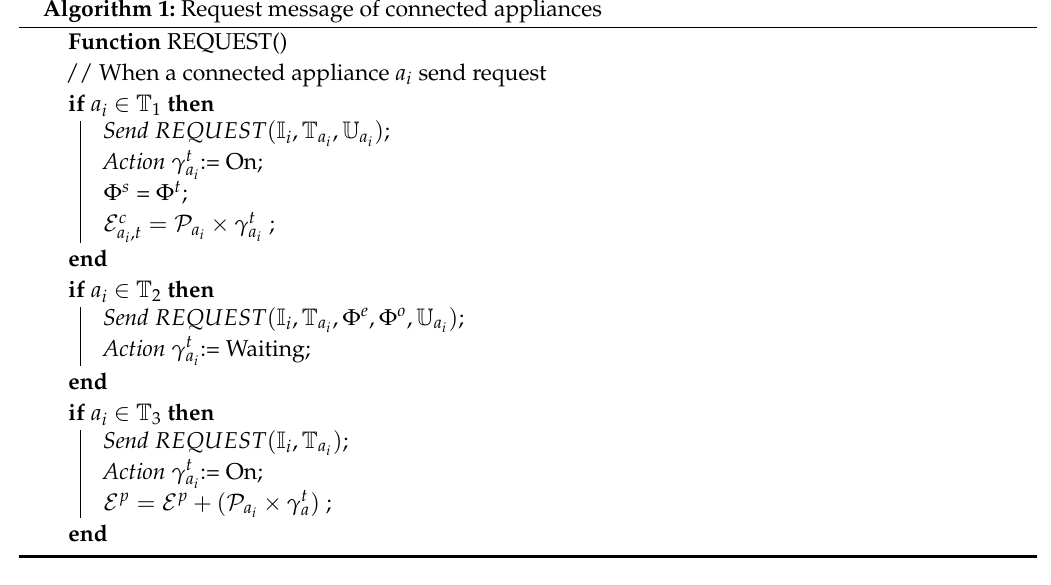
Algorithm 2: Reply message of connected